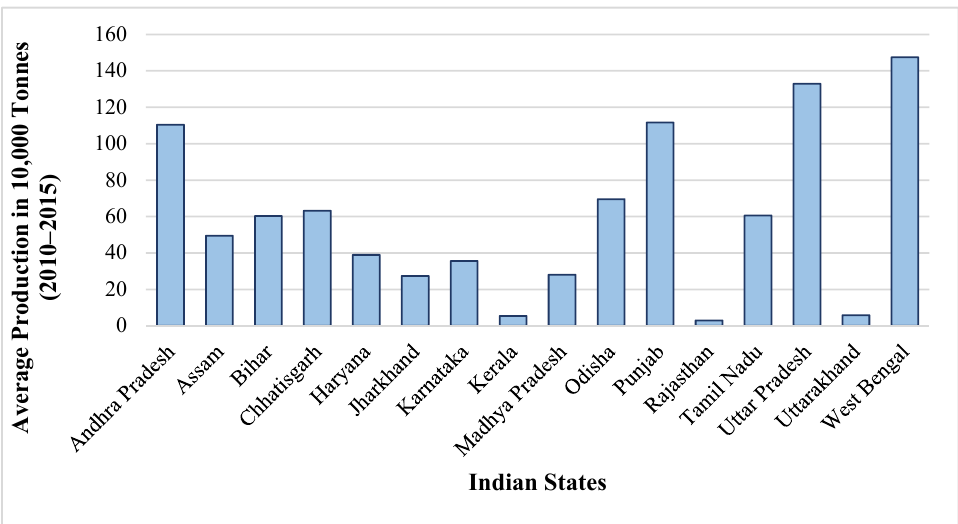
Figure 2. State-wise average rice production in India, 2010–2015. Source: Author’s elaborations using data from the Directorate of Economics and Statistics, India.